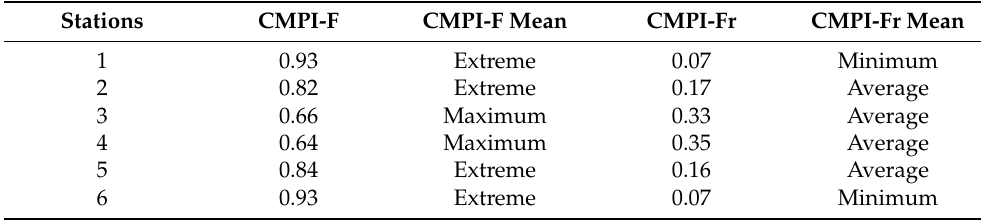
Table 3. Pollution status by MPs of the monitoring stations using the Microplastic Impact Coefficient (CMPI) in fibers (F) and fragments